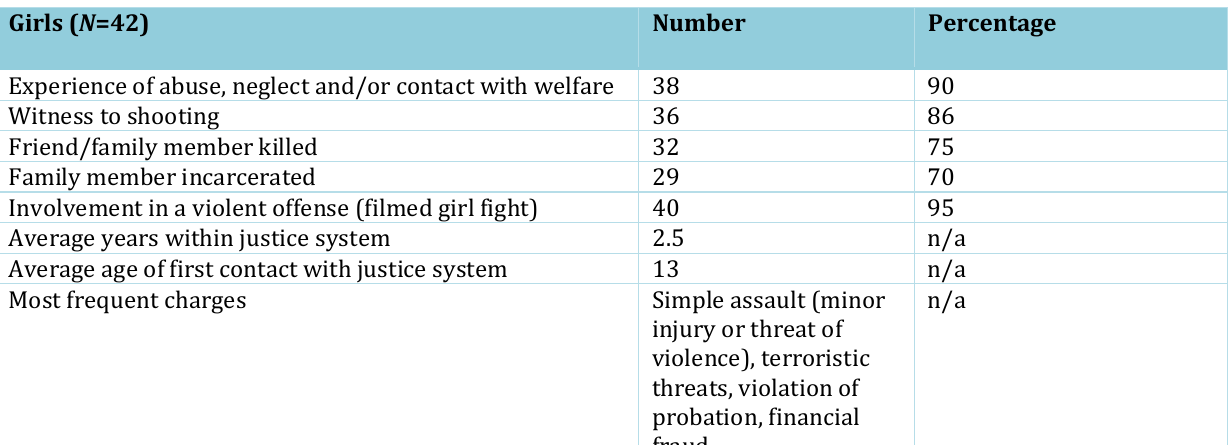
Table 2. Girls’ contextual